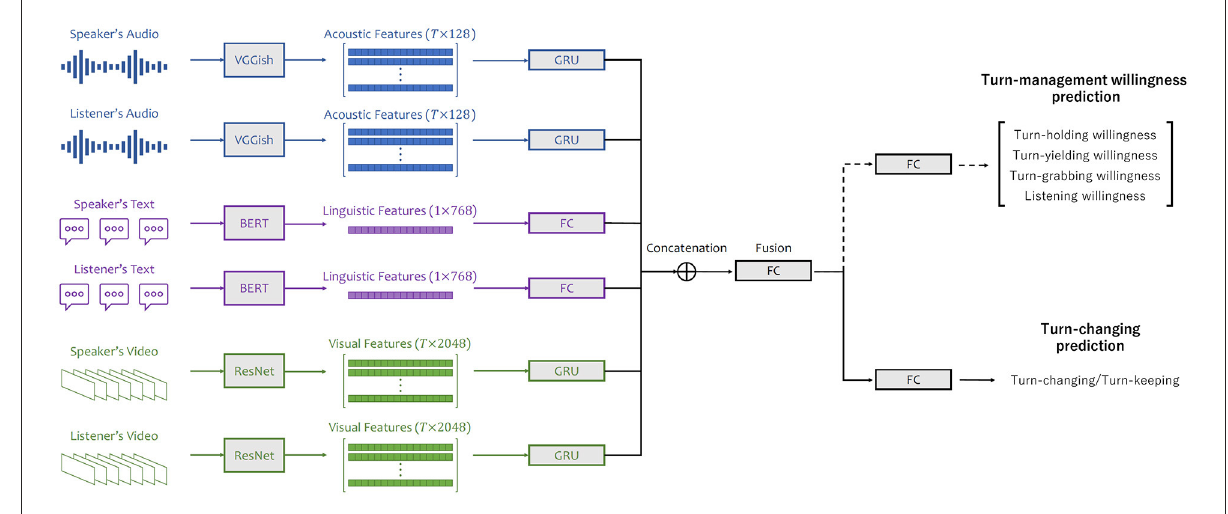
FIGURE6 Architecture of multi-task model with input features of acoustic, linguistic, and visual modalities from speaker and